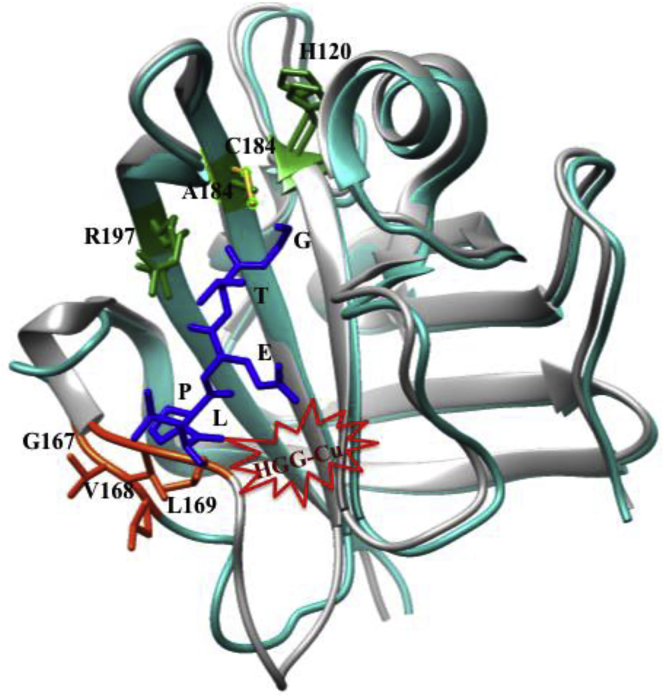
Inactivation of SrtAΔN59 Activity by Cu-ATCUNsSuperimpose crystal structures of SrtAΔN59 (Wild (cyano) (PDB ID: 1T2O (Suree et al., 2009)) and mutant Cys184Ala (gray) (PDB ID: 1T2W (Suree et al., 2009)) with substrate, LPETG (blue)). Cu-GGH (red star) is assumed to bind to the L residue of substrate where close proximity amino acid residues G167, V168, and L169, and G residue of substrate points toward the active-site amino acid R197-C184-H120. Modified from Fidai et al. (2014).